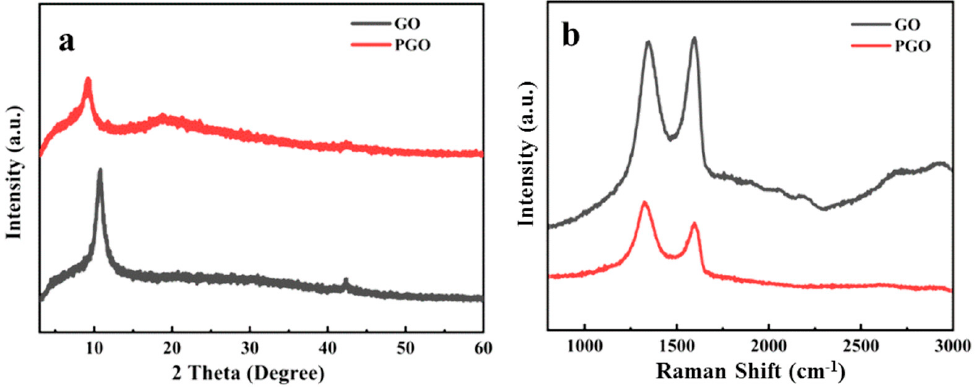
Figure 2. XRD pattern ( a ) and Raman spectra ( b ) of GO and PGO.